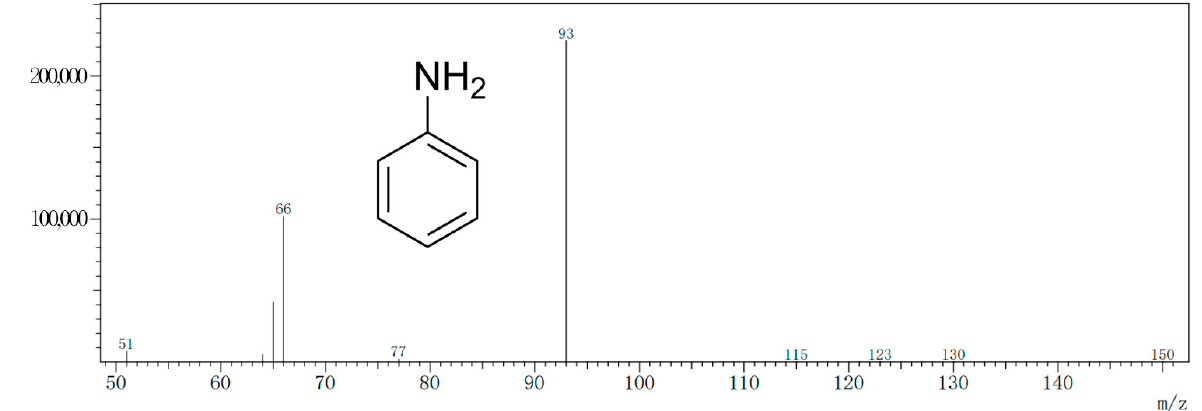
Figure 1. GC-MS extracted fragment ion mass-to-charge ratio chromatograms used to characterize aniline molecules. The quantitative ion of aniline is 93 ( m / z ), and the auxiliary ions are 65 ( m / z ) and 66 ( m / z ).